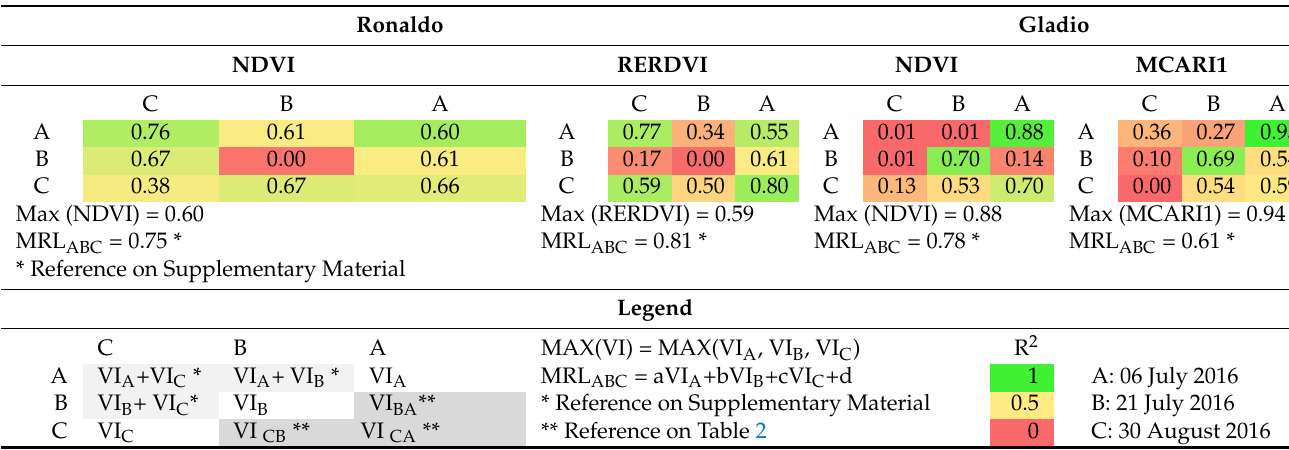
Table 5. R 2 of linear regression models for Ronaldo and Gladio variety using multitemporal VIs as independent variables and the yield as